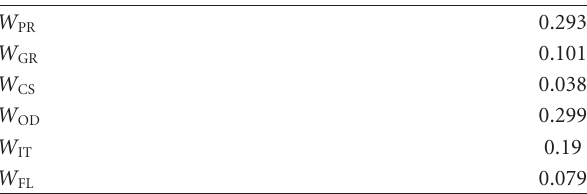
Table 3: Weights of criteria.